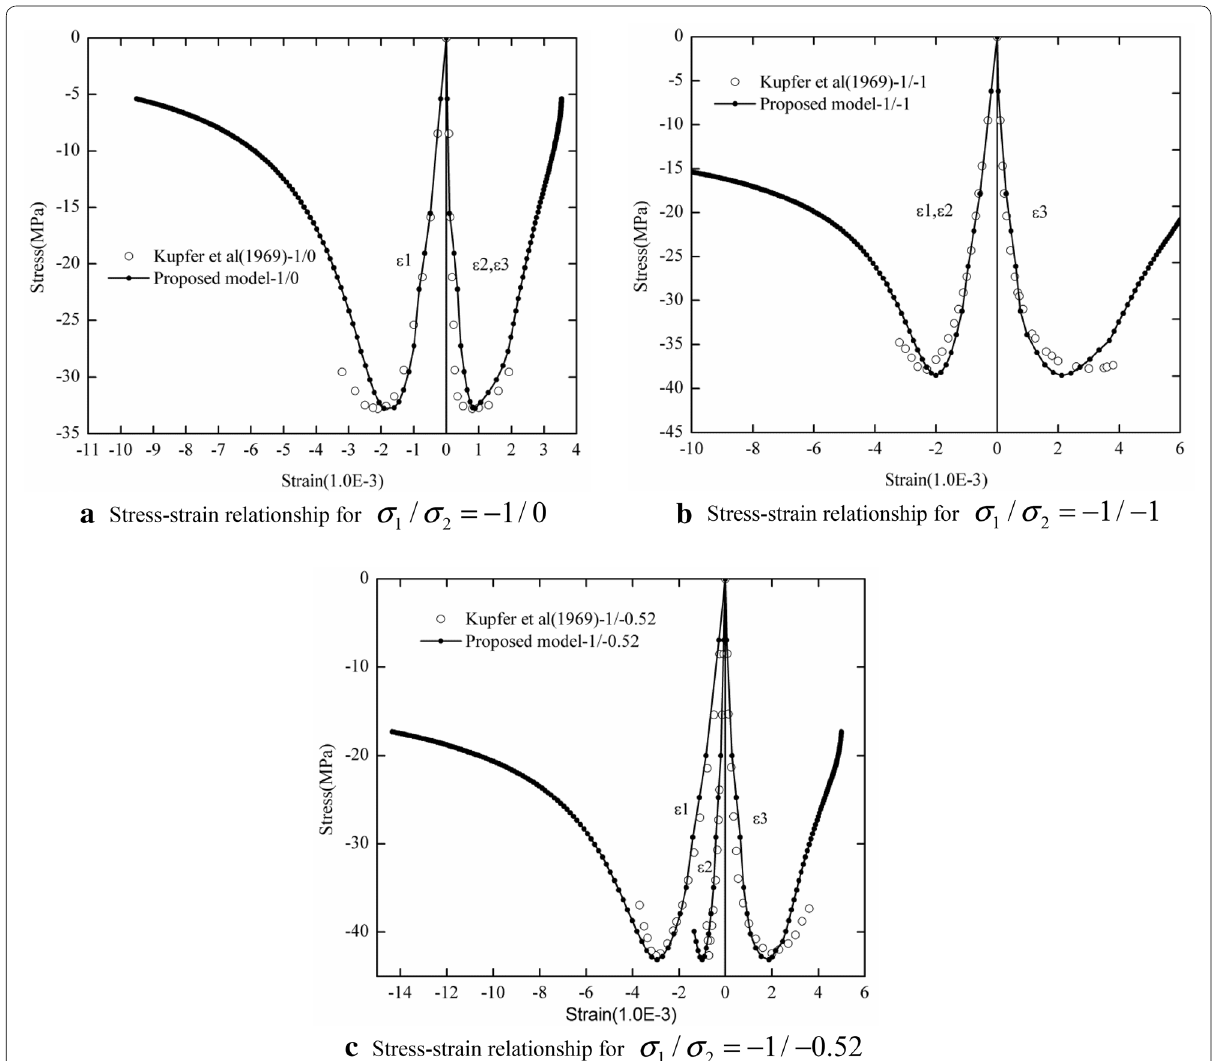
Fig. 10 The model responses in monotonic uniaxial and biaxial compressive loading compared to experimental results reported by Kupfer et al. (1969).